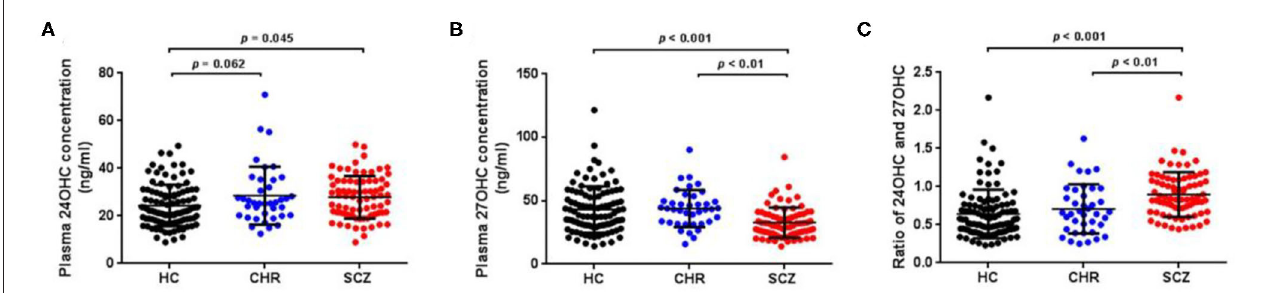
FIGURE 1 | Plasma oxysterols profile in schizophrenia (SCZ) patients, clinically high risk (CHR) individuals, and healthy controls (HC). The plasma 24OHC levels, 27OHC levels, and 24OHC/27OHC in SCZ patients, CHR, and HC are shown in (A) , (B) , and (C) , respectively. SCZ patients showed higher plasma 24OHC levels and lower 27OHC levels than